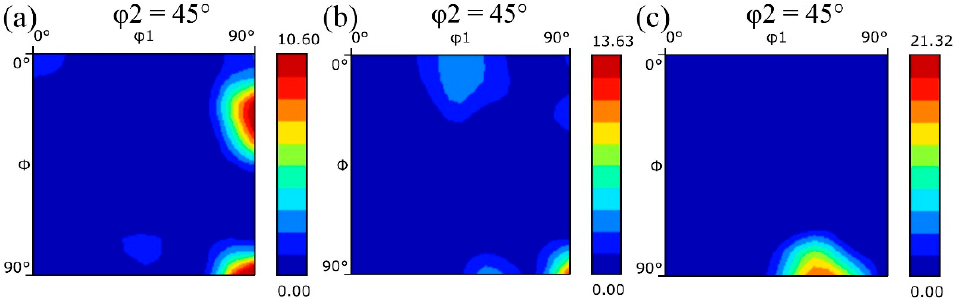
Figure 9. φ 2 = 45° ODF sections showing surface textures ( a ) 800 °C—78%, ( b ) 750 °C—78%, ( c ) 700 Figure 9. ϕ 2 = 45 ◦ ODF sections showing surface textures ( a ) 800 ◦ C—78%, ( b ) 750 ◦ C—78%, °C—78%. ( c ) 700 ◦ C—78%.